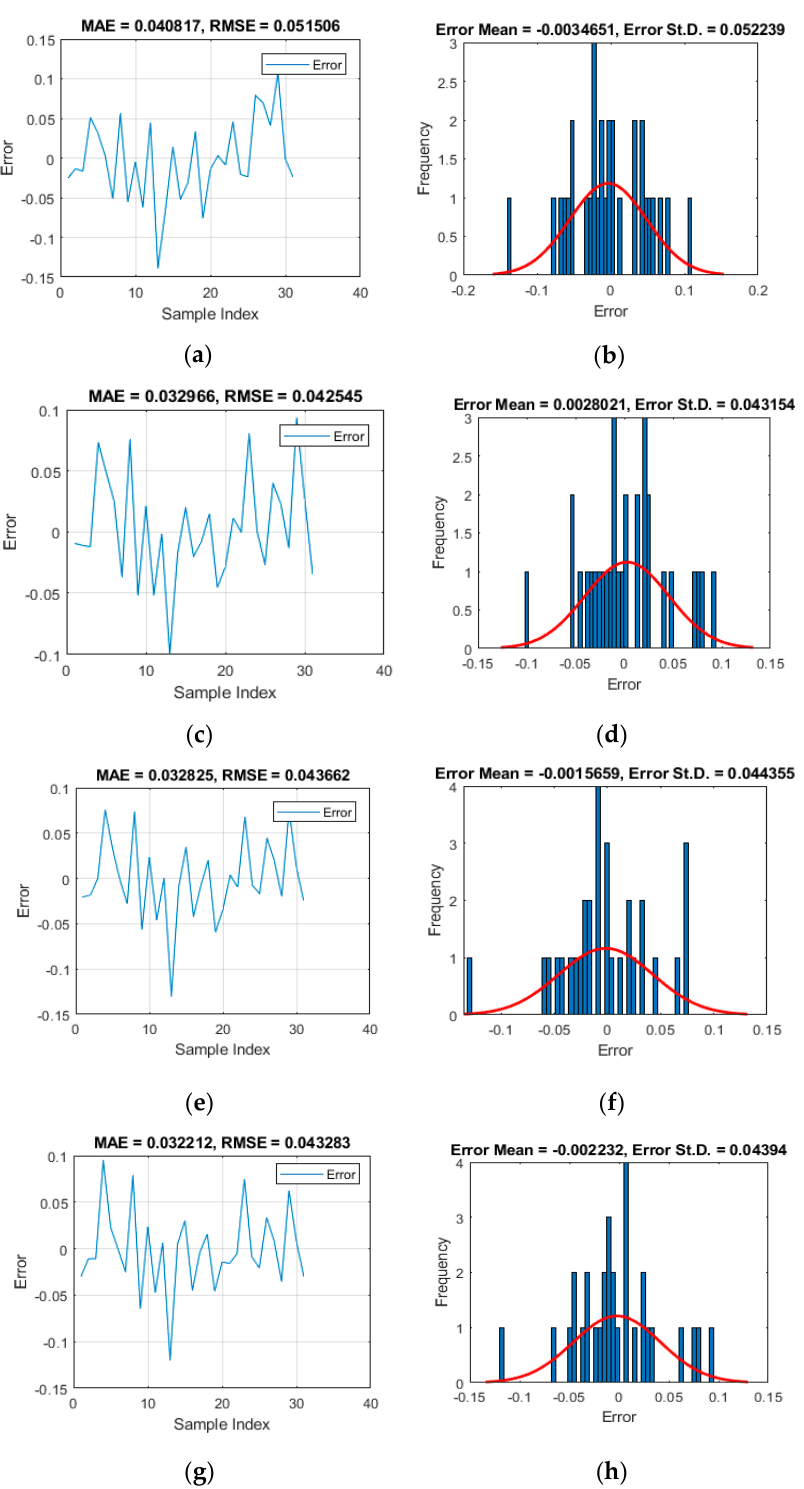
Figure 9. The testing results obtained for ( a ) ANN, (b) ANN frequency, ( c ) DA-ANN,(d) DA-ANN frequency ( e ) WOA-ANN, (f) WOA-ANN frequency, ( g ) IWO-ANN (h) IWO-ANN frequency predictions.